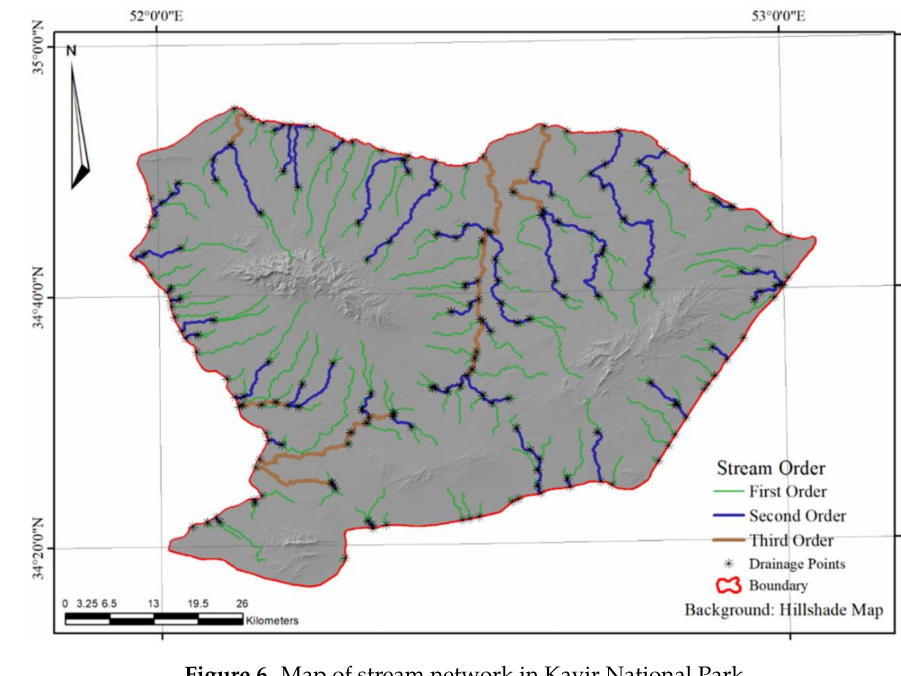
Figure 6. Map of stream network in Kavir National Park.